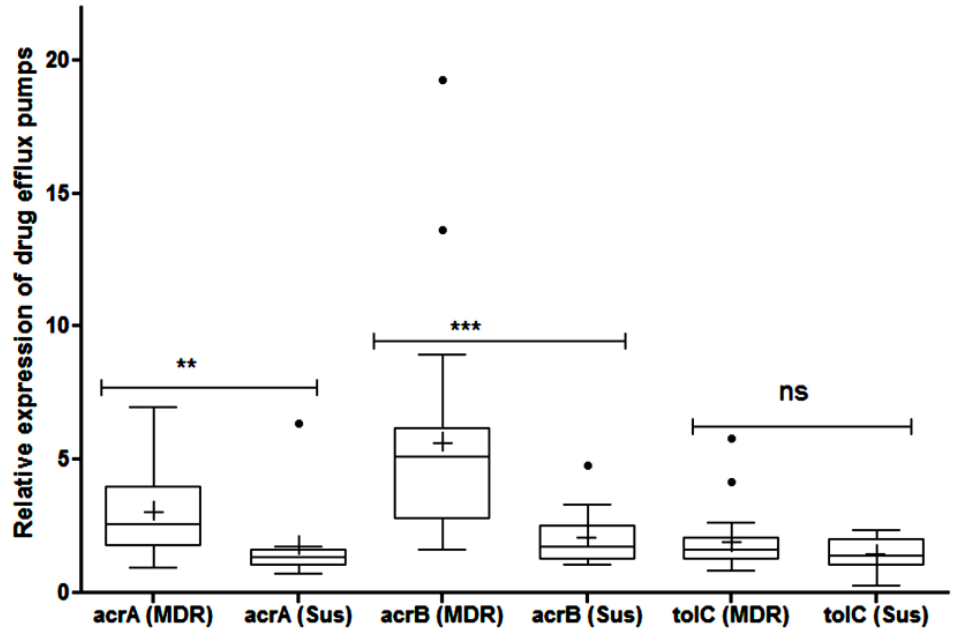
Figure 2. Relative expression of efflux pump system ( acr A, acr B and tol C) in multi-drug resistant and pan-susceptible Escherichia coli isolates of caprine origin as determined by qPCR with respect to its housekeeping gene rps L. Each group is represented by median (-), mean (+), and 95% confidence interval. ns—non-significant, ** ( p < 0.01), *** ( p < 0.001) and • (outliers).